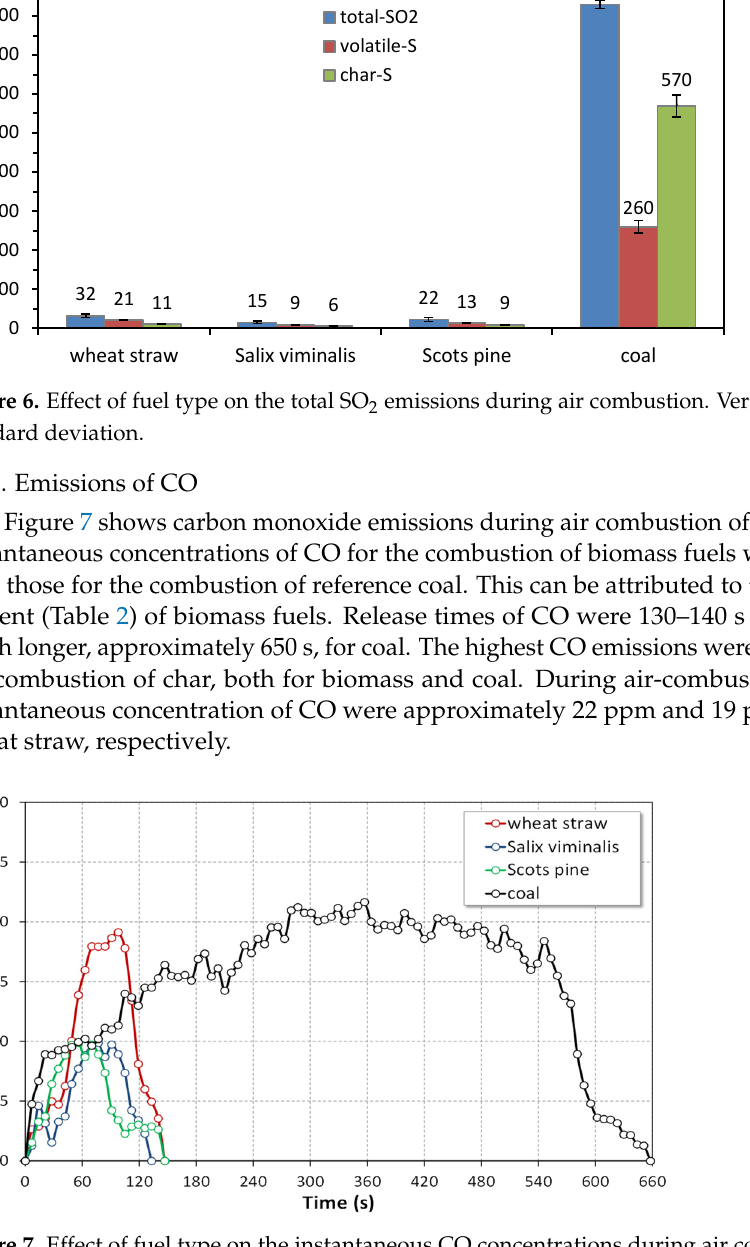
Figure 5. The instantaneous concentrations of SO 2 during air combustion.